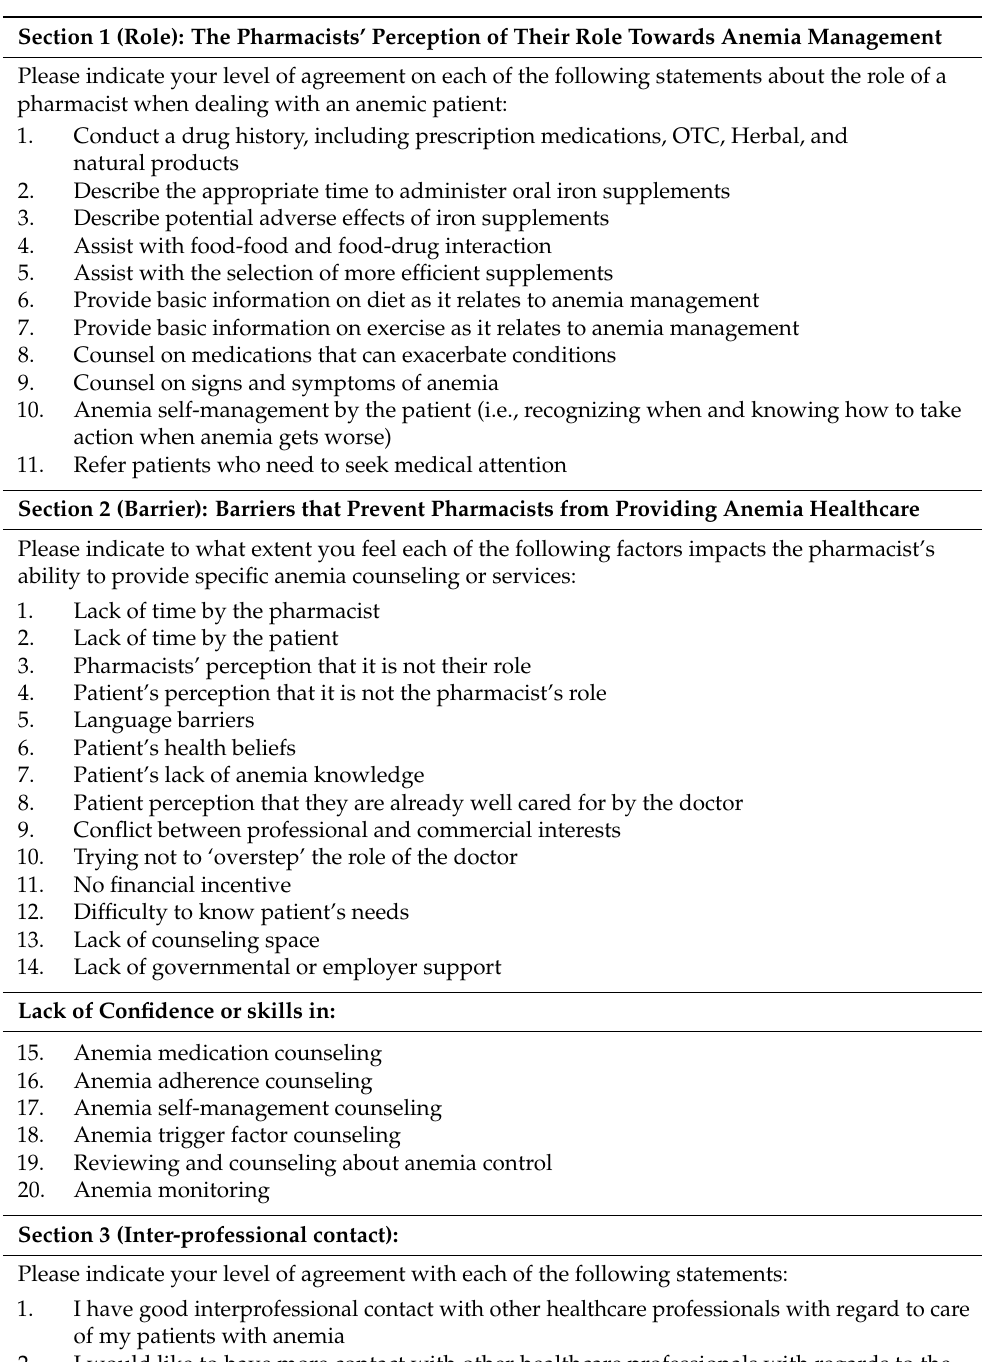
Table 1. The 33-item community pharmacist’s role in anemia management